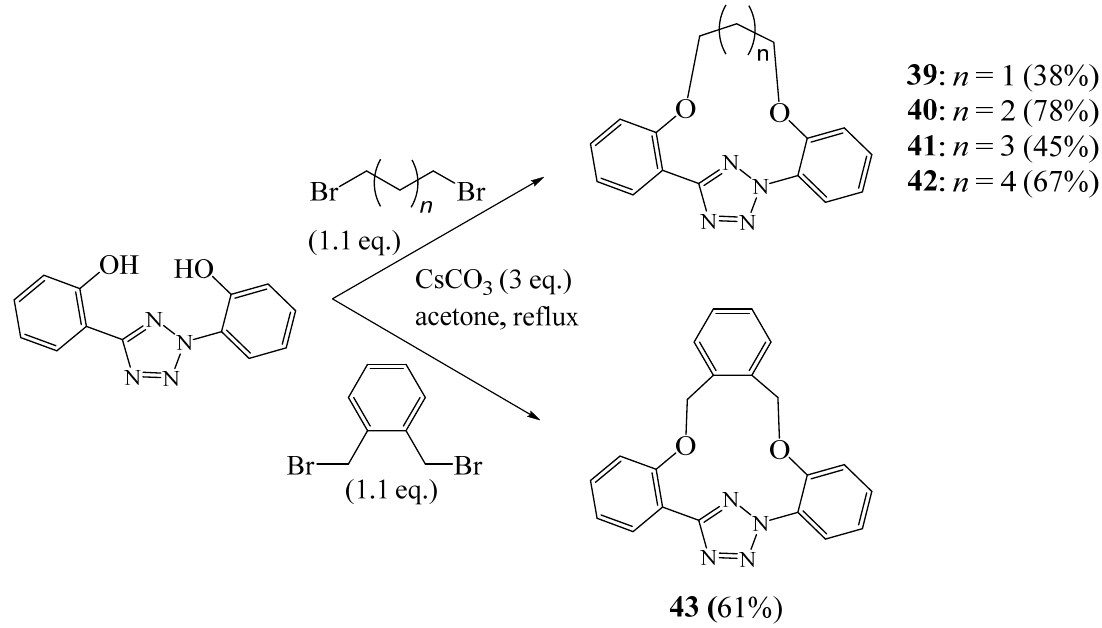
Figure 13. Synthesis of montetrazolic macrocycles 39 − 43. (Reprinted with permission from ref. [28]. Copyright 2010 John Wiley and Sons).